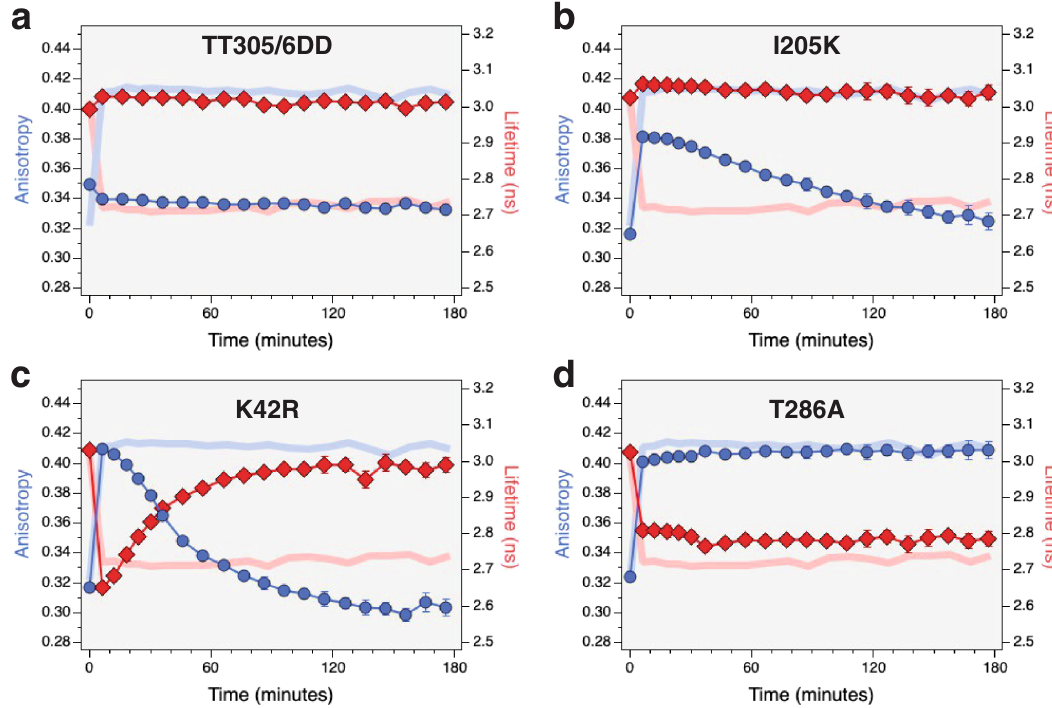
Fig. 5 | In vitro binary-FRET analysis of mVenus-tagged mutant CaMKII α holoenzyme association with mCherry-tagged NR2B binding fragment. The TT305/6DD mutant ( a ), I205K mutant ( b ) K42R mutant ( c ), and T286A mutant ( d ) wereactivatedwithexcesscalciumcalmodulininabuffercontaining1mMATPand 10-foldexcessmCherry-taggedNR2B-bindingfragment.Anisotropymeasurements are depicted as blue circles while lifetime measurements are depicted as red